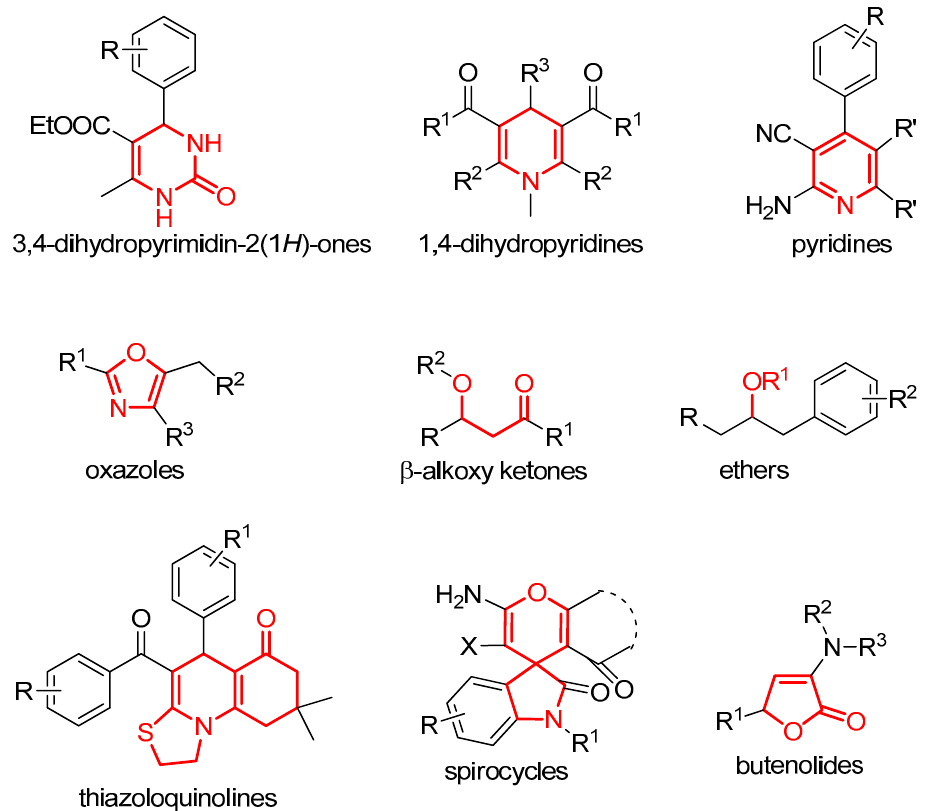
Figure 1. Structural cores described in this review and synthesized by means of gold-catalyzed MCRs.